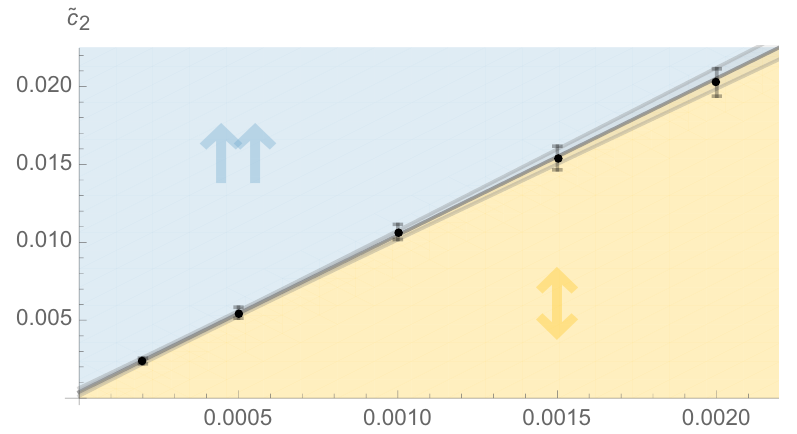
Figure 8 . Large N extrapolation of the l→↑↑ transition line. Pale-gray stripes represent 68% confidence